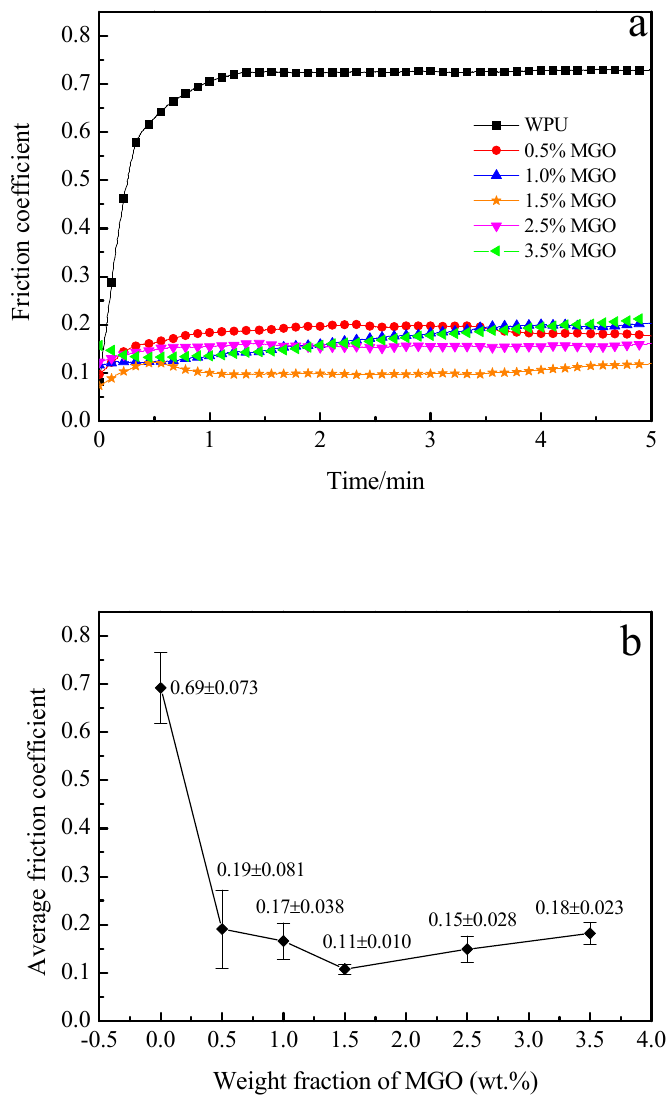
Figure 4. Friction coefficient of MGO/WPU composite coating with different mass fractions of MGO, ( a ) real-time friction coefficient, ( b ) average friction coefficient. (Applied load is 3.5 N; test duration is 5